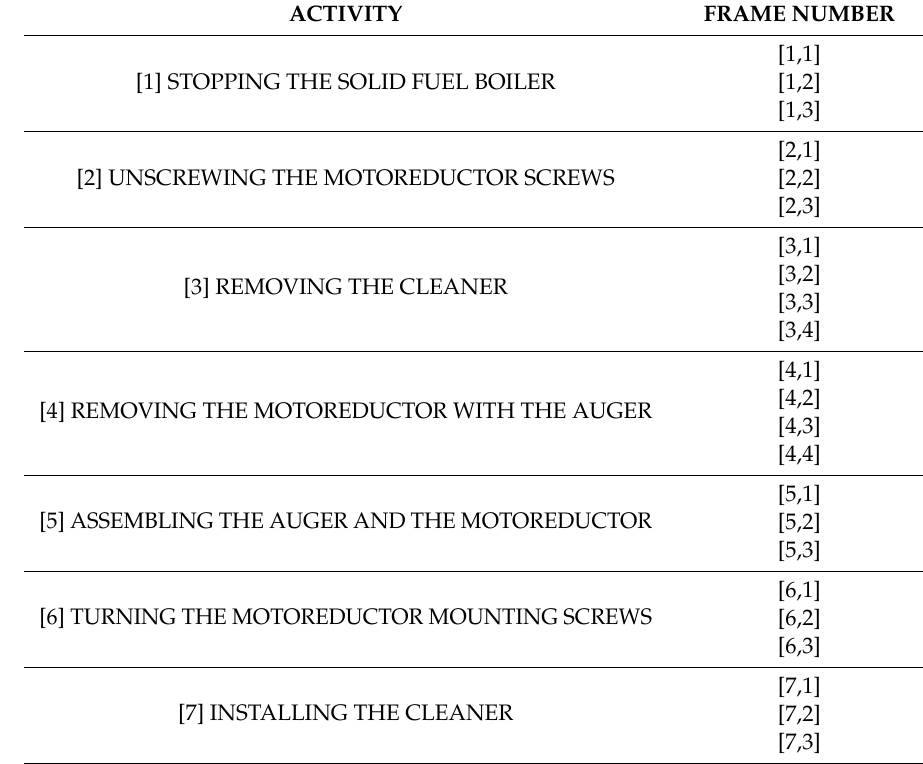
Table 2. Activities and reference frames associated with each stage of the